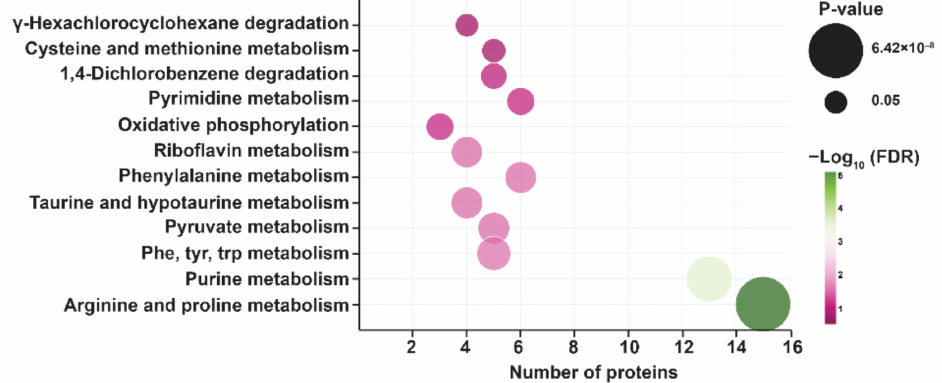
Figure 3. Pathway enrichment with significant p -value and FDR is shown as a bubble plot. The size of the bubble represents the p -value and color scale represents FDR for each